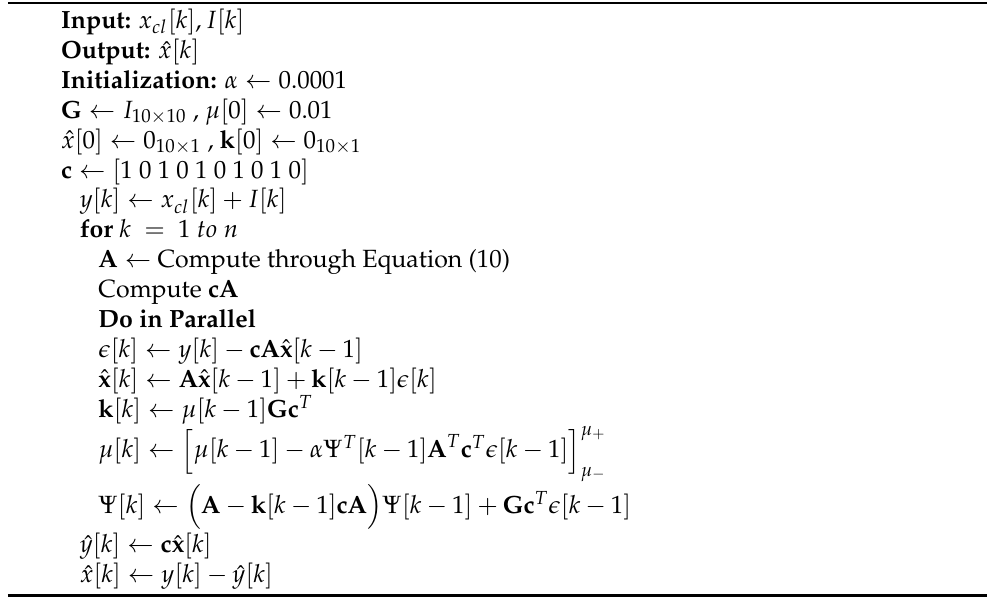
Algorithm 1: Pseudocode of the proposed PD-SSLMSWAM